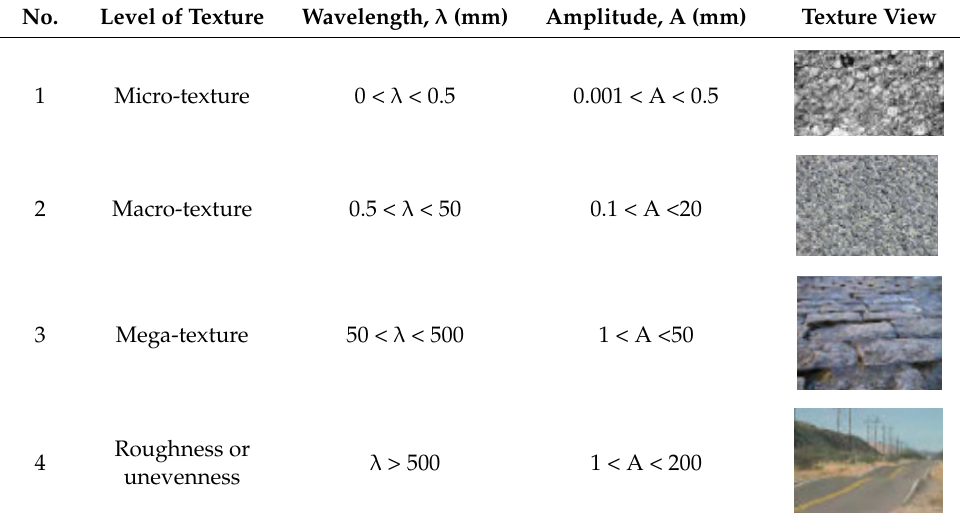
Table 2. Pavement texture classification according to the wavelength and amplitude (modified from [26]).